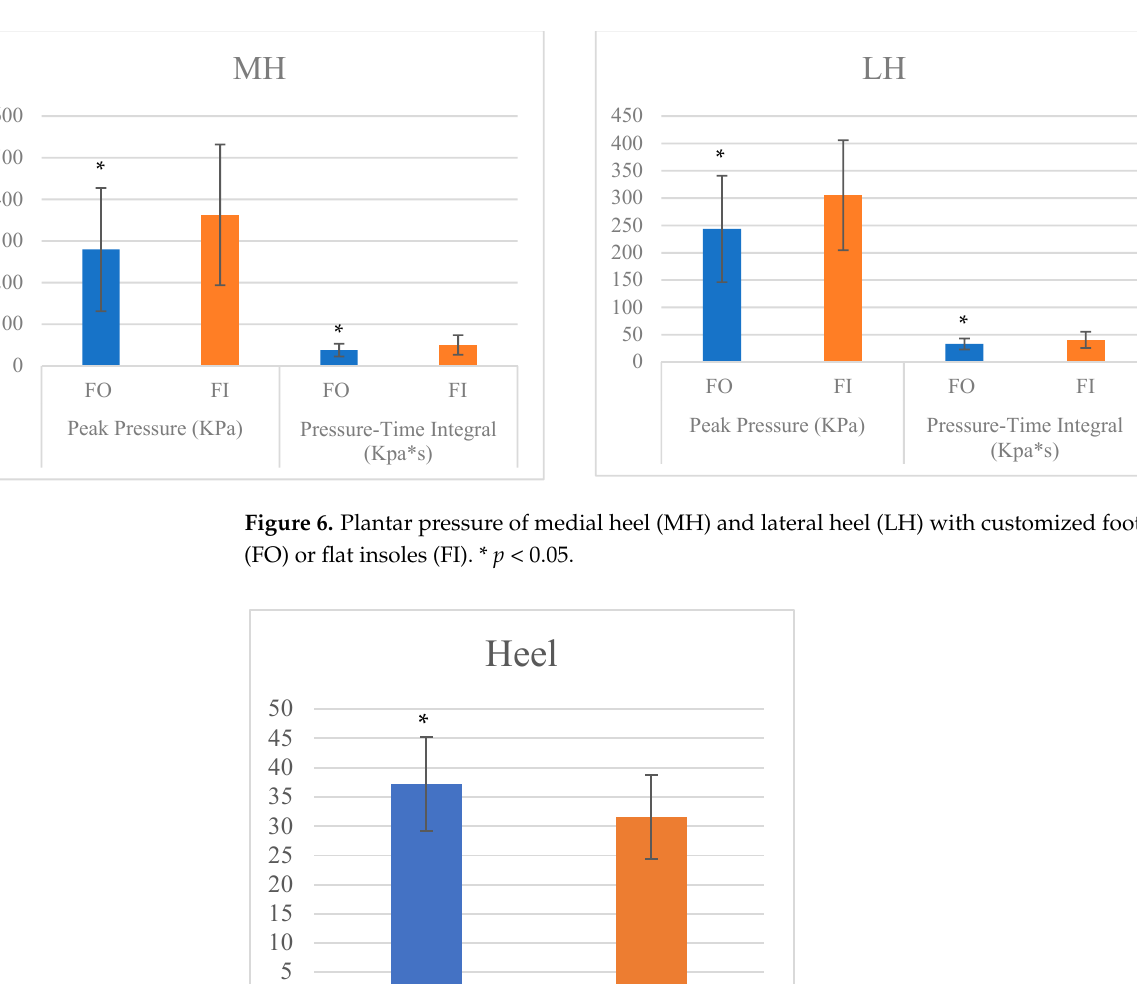
Figure 7. Contact area of heel with customized foot orthosis (FO) or flat insoles (FI). * p < 0.05.